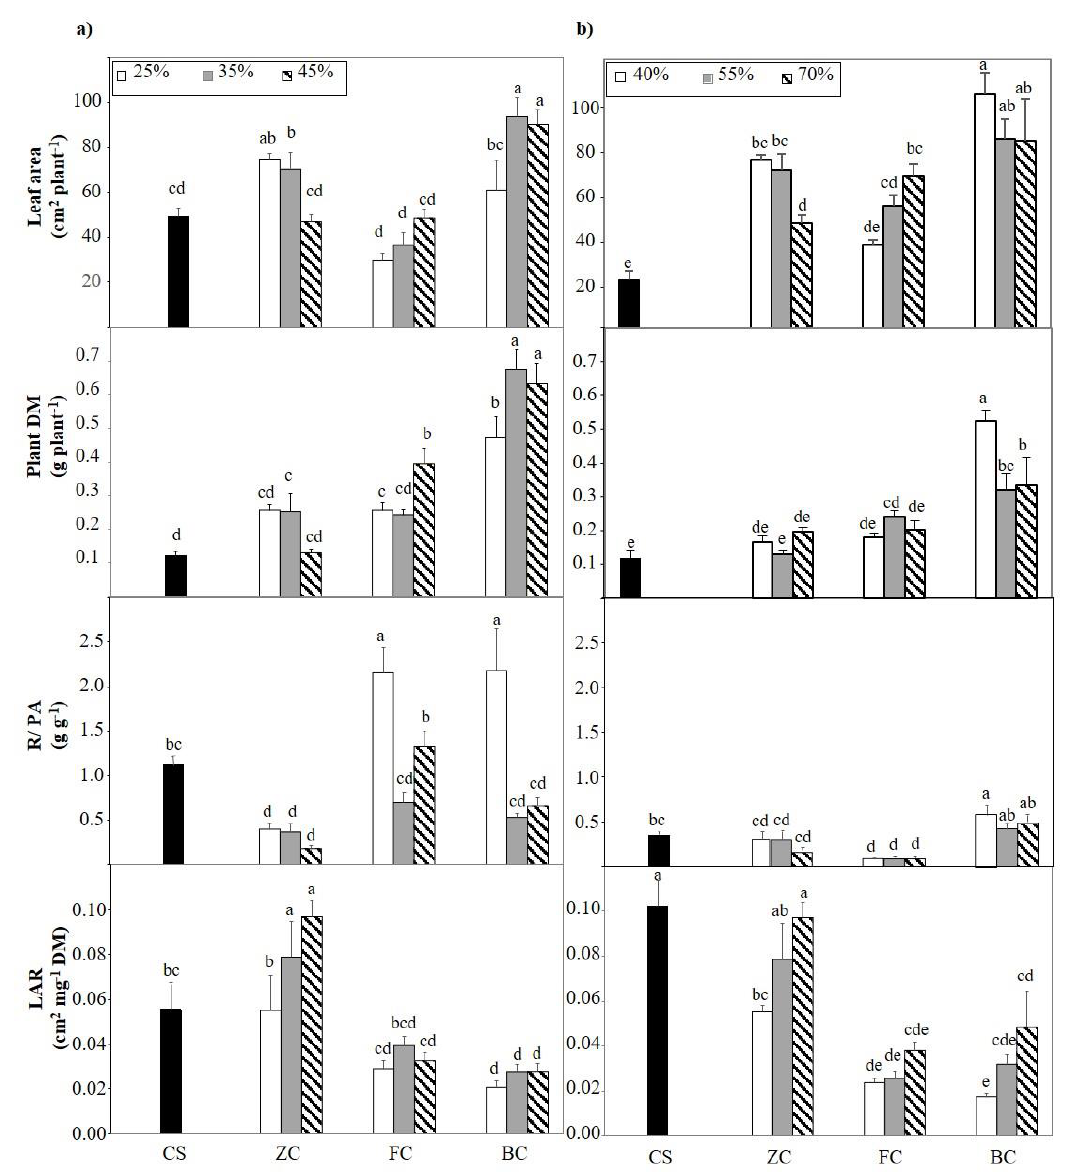
Fig. 2 Some plant growth parameters of a) pepper and b) tomato seedlings grown in perlite amended with different doses of